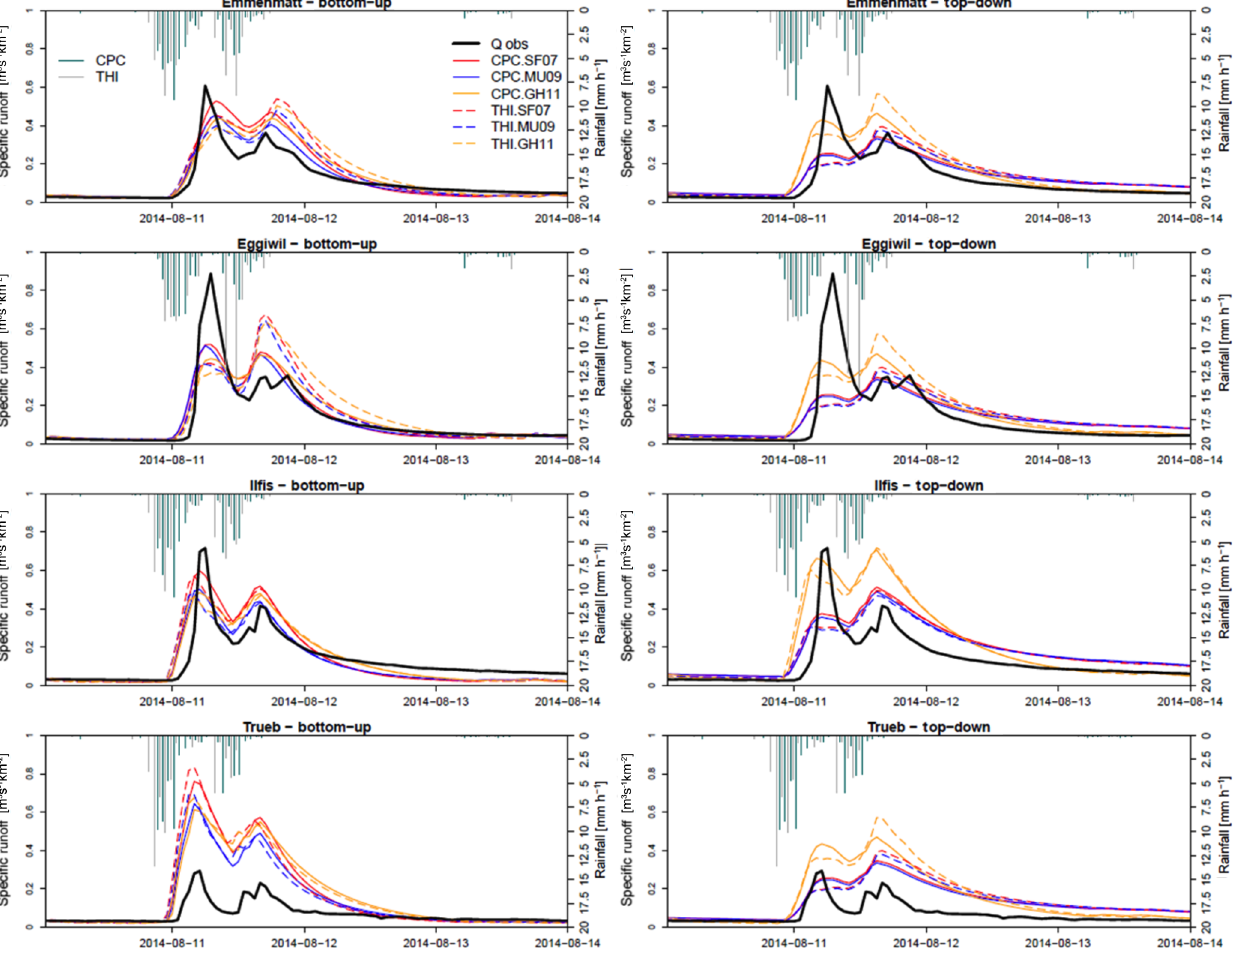
Figure 9. Simulated runoff for the four study catchments during the long-duration event of May 2016, obtained from different input data (CPC = Combiprecip; THI = Thiessen polygons), process maps (SF07, MU09 and GH11), and model set-ups (bottom-up and top-down). The simulated hydrographs refer to the first run of the Monte Carlo simulation performed with the corresponding modelling chain combination. Errors linked with the input data (e.g. the overestimation of the second runoff peak at Emmenmatt and Eggiwil due to a higher input signal) can be distinguished from those more clearly linked with the model